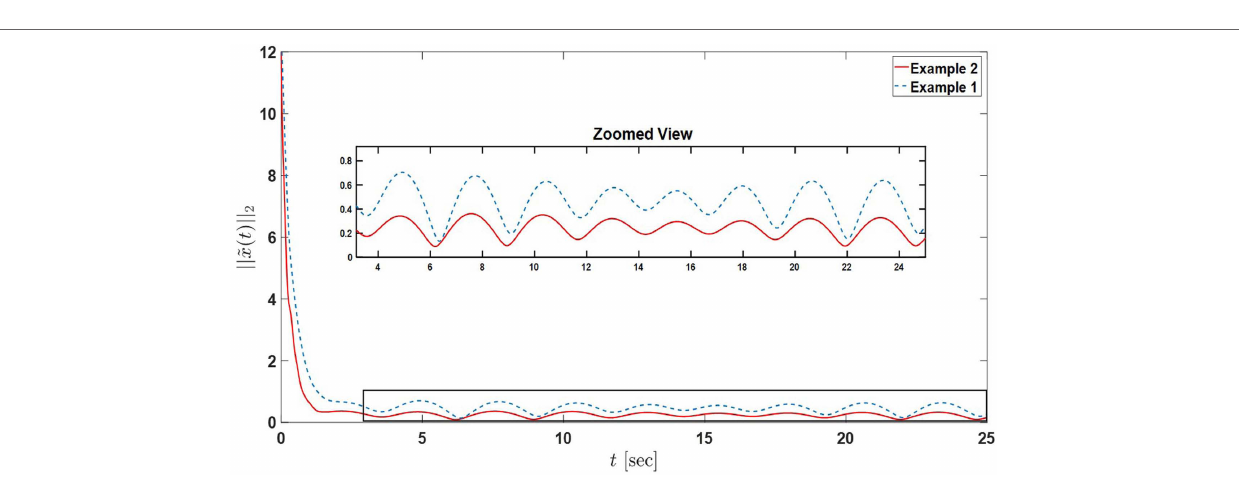
FIGURE 8 | State error norms of the sensor networks in Example 1 and Example 2.